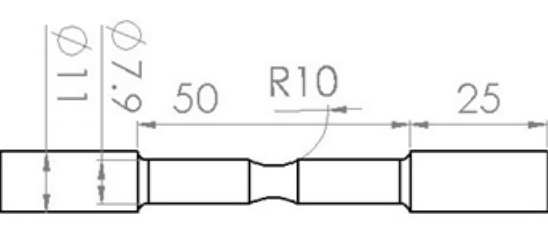
Figure 4. Dynamic test specimens.